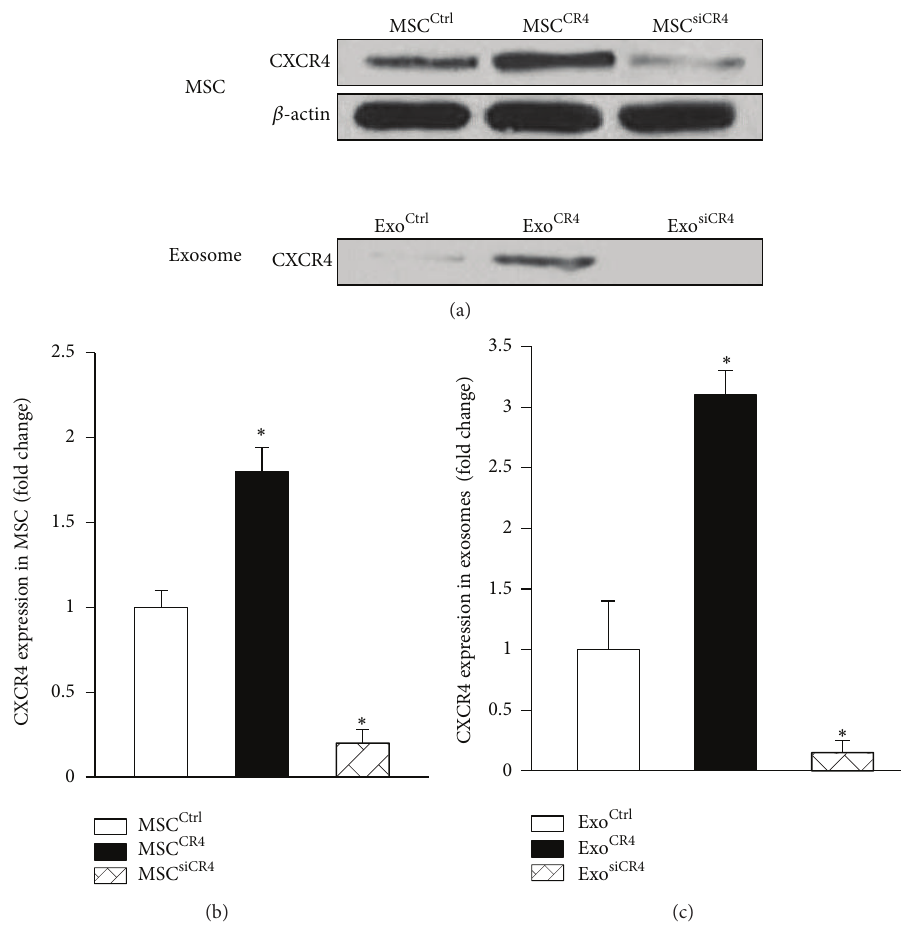
Figure 2: Expression of CXCR4 in MSC and MSC-derived exosomes. (a) CXCR4 expression was identified by Western blotting in MSC from various groups with quantitative analysis. ((b) and (c)) The expression of CXCR4 in MSC-derived exosome was detected by Western blotting and quantitative analysis. All values expressed as mean ± SEM. ∗ 𝑃 < 0.05 versus MSC ctrl or Exo Ctrl , 𝑛 = 4 for each